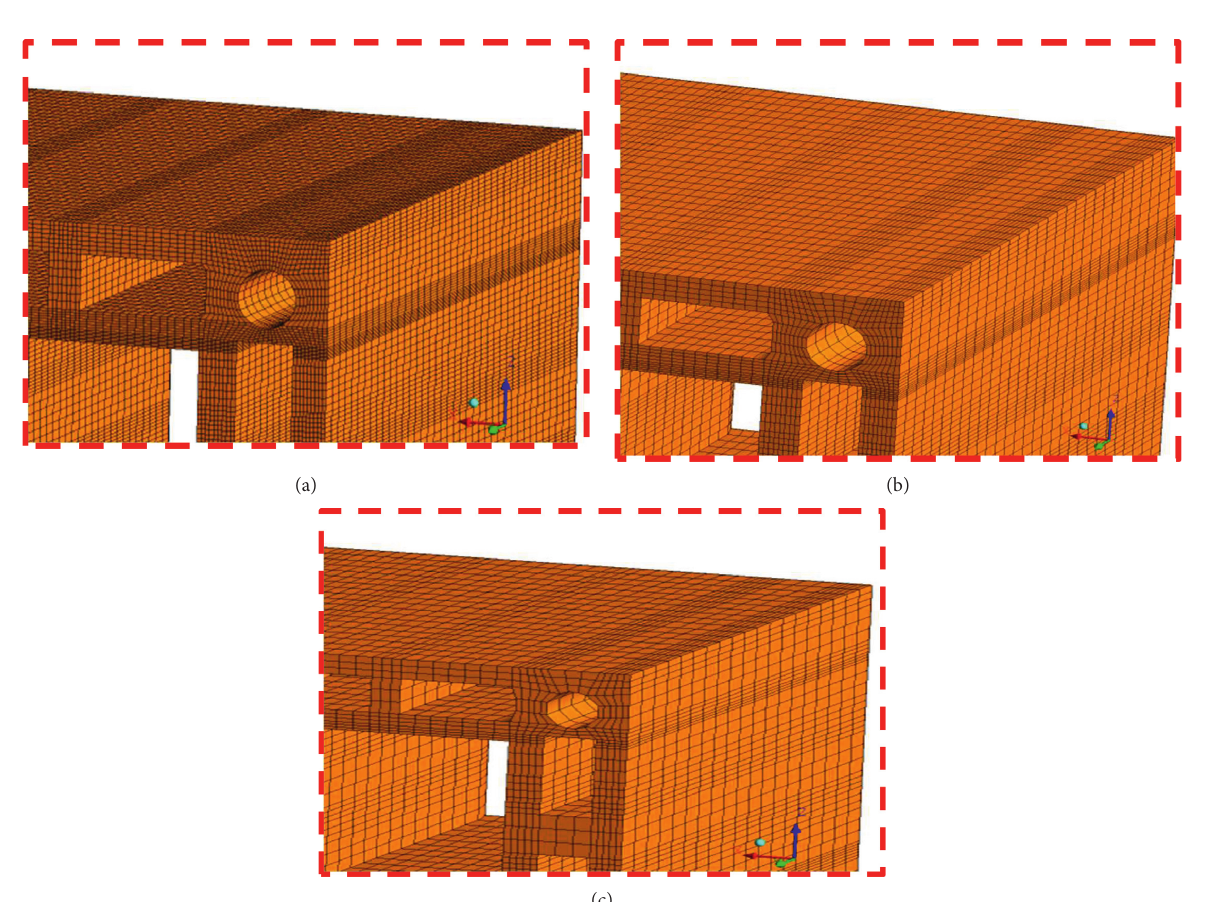
Figure 5: Representation of the computational mesh of the brick. (a) M1. (b) M2. (c)